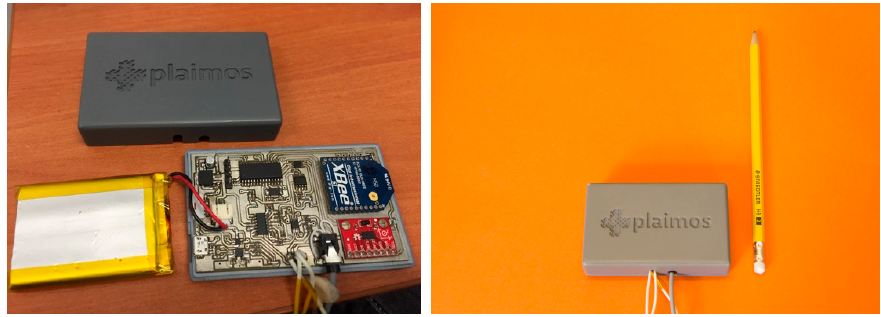
Figure 10. The PlaIMoS remote node device.